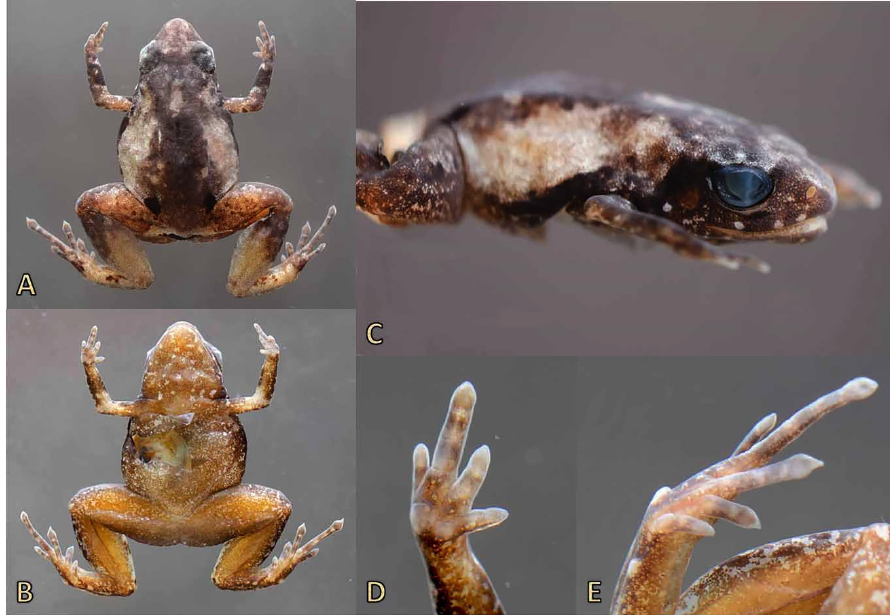
Figure 2. Photographs of preserved specimen of Noblella losamigos sp. n.: Adult female holotype MUSA 6973 (SVL 10.7 mm): ( A ) Dorsal view, ( B ) ventral view, ( C ) lateral view, ( D ) right hand, and ( E ) right toe. Photographs by Rudolf von May.